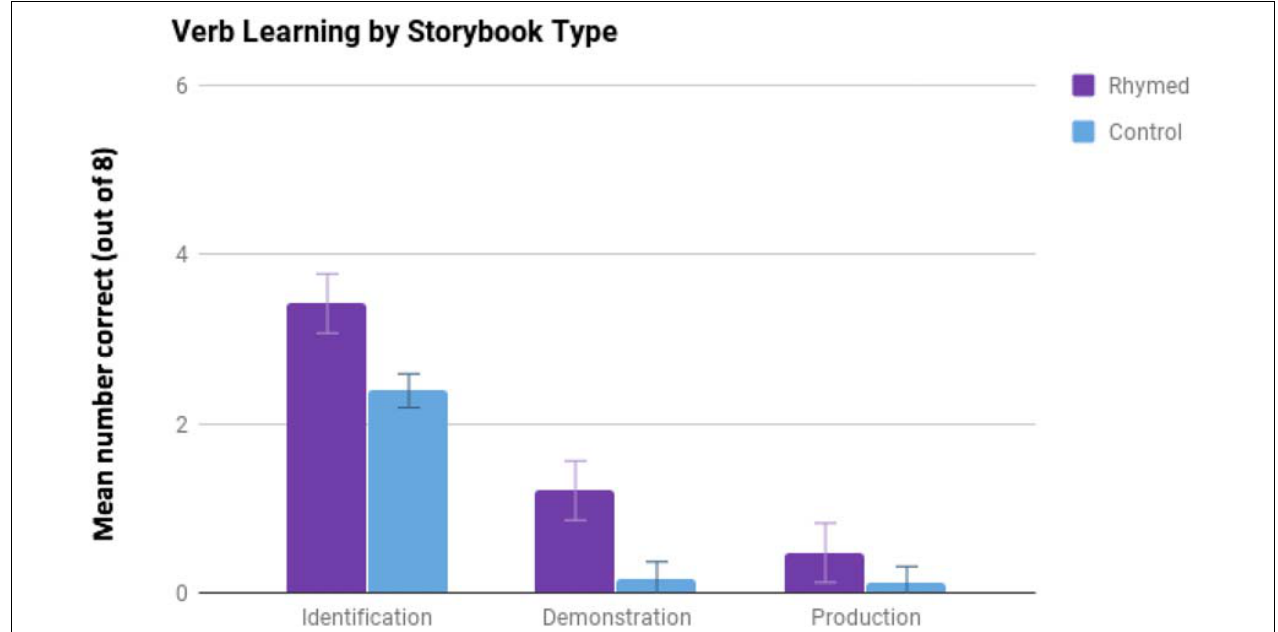
FIGURE 2 | Mean correct scores for children in each test by condition. Error bars represent standard error of the mean for each